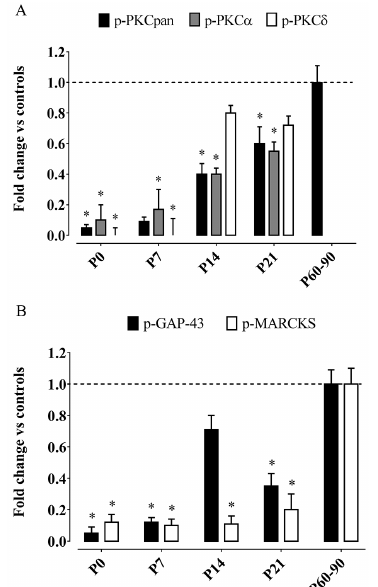
Figure 1. Phosphorylation of protein kinase C (PKC) and PKC substrates are reduced in developing hippocampus of α -tocopherol-exposed pups. ( A ) PKCpan, PKC α and PKC δ phosphorylation in the hippocampus of developing offspring and PKCpan phosphorylation in the hippocampus of adult offspring; ( B ) Phosphorylation of PKC substrates GAP-43 and MARCKS in the hippocampus of developing and adult offspring. Hippocampal protein extracts taken from CTRL and TREAT developing and adult offspring (at each time point, for each group, n = 8 animals from four different litters) were subjected to SDS/PAGE (12% polyacrylamide for PKCpan, PKC α , PKC δ and GAP-43 and 7% polyacrylamide for MARCKS) followed by Western blotting, using polyclonal phospho-specific antibody directed to PKCpan, PKC α , PKC δ , GAP-43 and MARKS. Histograms represent densitometric analyses of blots from three independent experiments (means ± S.E.M.). Representative CTRL value is shown as dashed line. Relative decreases in band absorbance values (arbitrary units) were normalized for the control band in each series. Student’s t test: * p < 0.05. Figure modified from [78]. GAP: growth associated protein; MARCKS: myristoylated alanine-rich C-kinase substrate; CTRL: control, untreated; TREAT: treated.